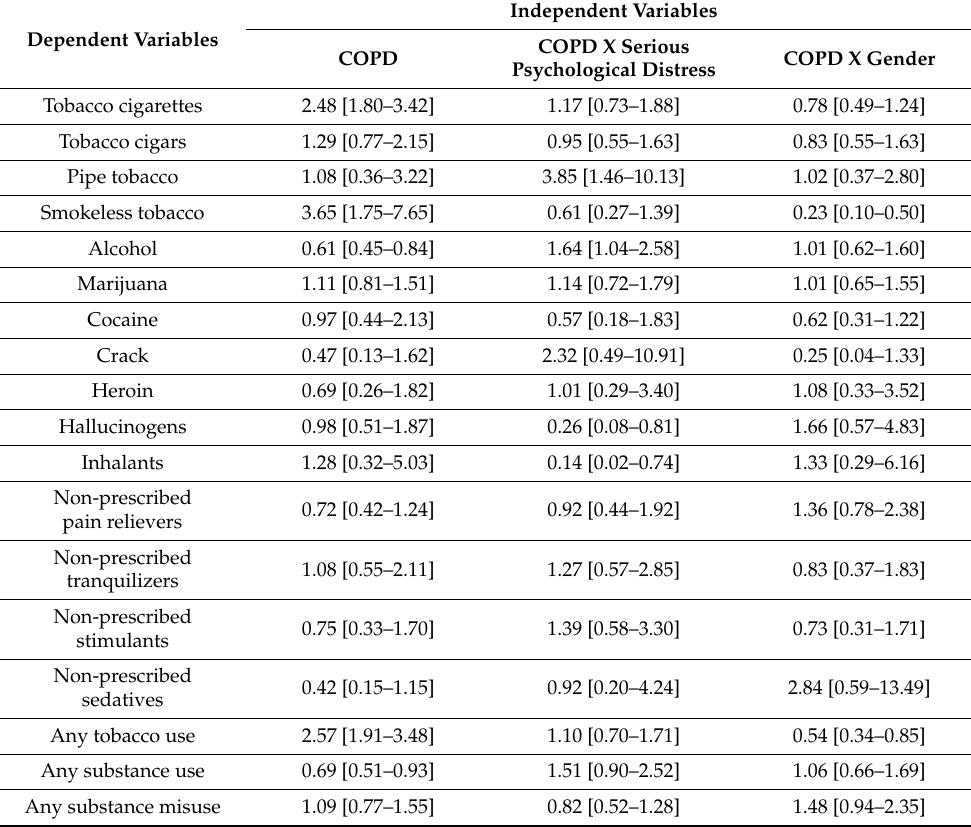
Table 3. The association between adults with COPD and last-month substance